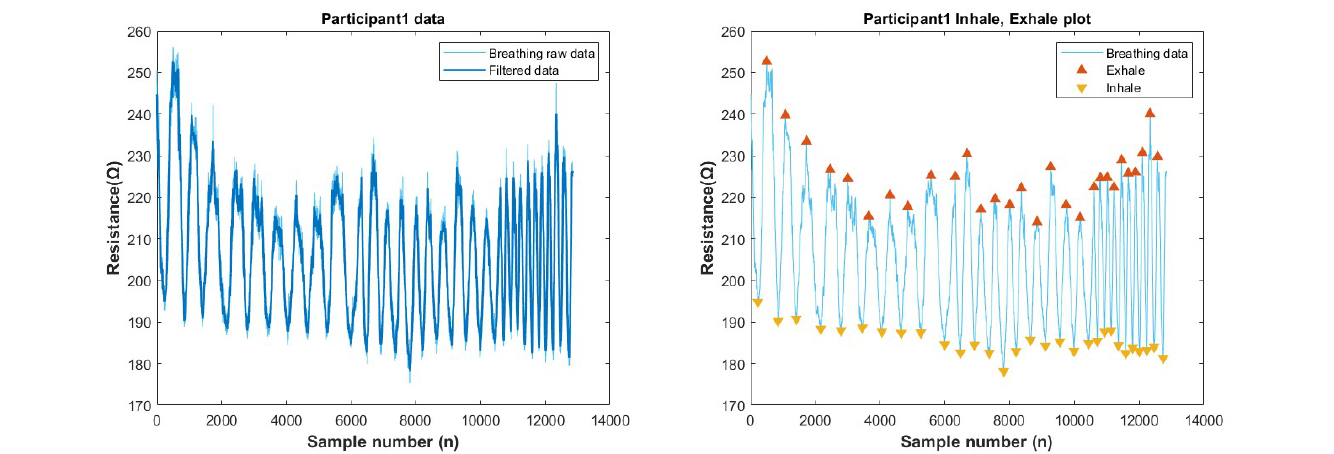
Figure A16. Breathing Test data of Participant